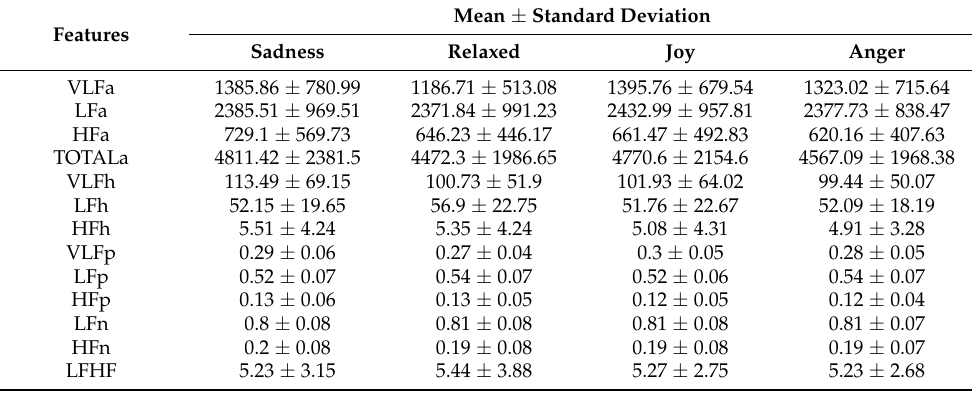
Table 7. Statistics of frequency domain feature values.